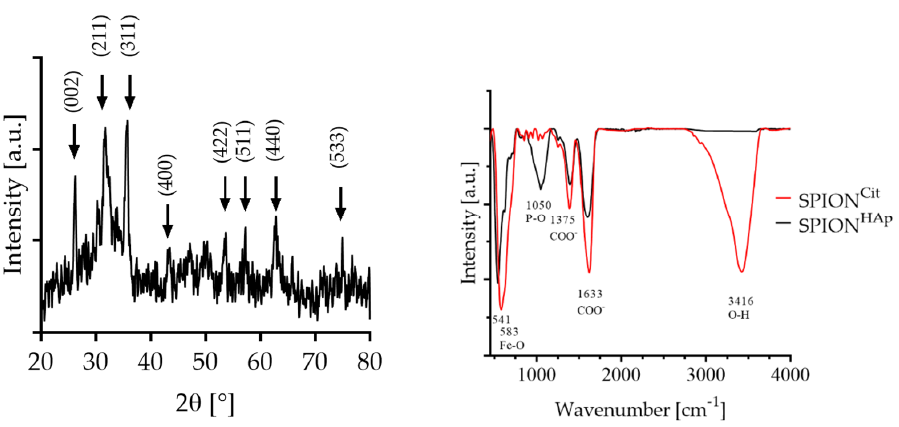
Figure 3. Right: XRD of SPION HAp with magnetite/maghemite-related characteristic peaks at 2θ = 35.6°, and for hydroxyapatite/hydroxyapatite at 2θ = 32.4°. Left: FTIR-spectra of SPION Cit with a Fe-O peak at 541 cm −1 and SPION HAp with a Fe-O peak at 583 cm −1 and P-O at 1050 cm −1 .